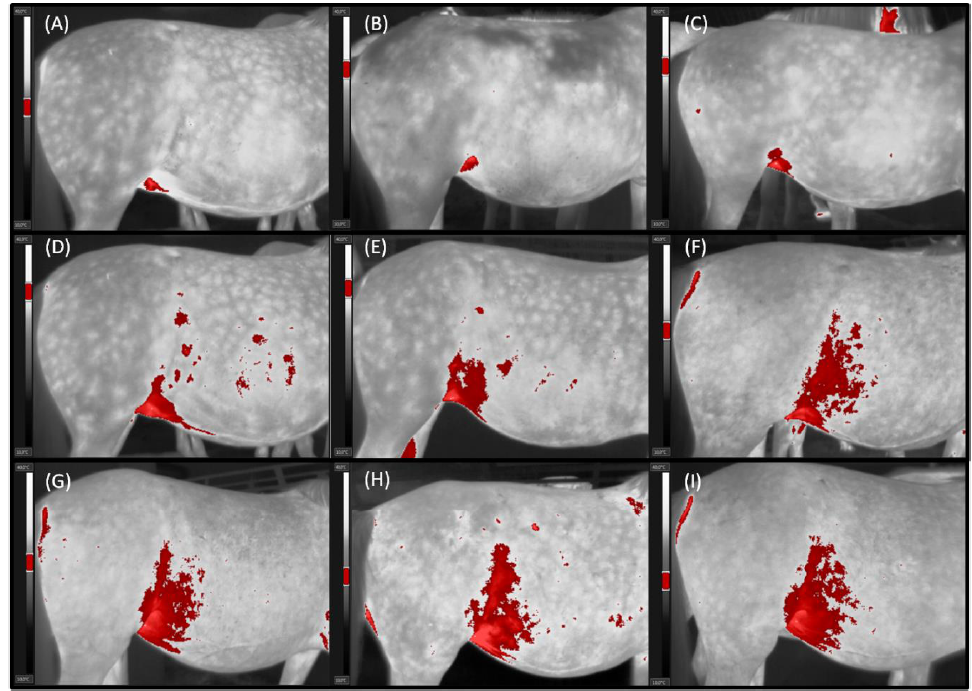
Figure 2. Thermal images in gray palette of the mare. The area with the highest temperatures in the range of 3 °C (Area of Tmax) marked in red in the following months of pregnancy: third ( A ), fourth ( B ), fifth ( C ), sixth ( D ), seventh ( E ), eighth ( F ), ninth ( G ), tenth ( H ), and eleventh ( I ). In the pregnant group, months with the highest values of measured temperatures, both ambient and surface, corresponded with the highest E1S concentration. In the preg- nant group, the E1S concentration increased gradually throughout the first four months of pregnancy with a significant increase at month five and was maintained above 100 ng/mL from the sixth to nineth month. Then, a significant decrease to the initial baseline was noted. In the non-pregnant group, no differences in E1S concentrations were found between the studied months. The E1S concentration was higher in pregnant than non- pregnant groups between the second and tenth months (Table 2). In the pregnant group, the concentration of E2 was low in the first month, then increased during the second month to the highest concentration above 100 pg/mL at the third month. The gradual de- crease in E2 concentration was noted at the fourth and fifth months to the initial baseline comparable to the first month. Some E2 concentration decreases were noted at the ninth and eleventh month of gestation (Table 2). In the non-pregnant group, no differences in E2 concentrations were found between the studied months. The E2 concentration was higher in the pregnant than non-pregnant group between the second and fifth months. No evidence of association between E1S concentration (Figures 3 and 4) or E2 concentra- tion (Figures 5 and 6) and thermal features of the lateral surface were observed both in pregnant and non-pregnant groups.